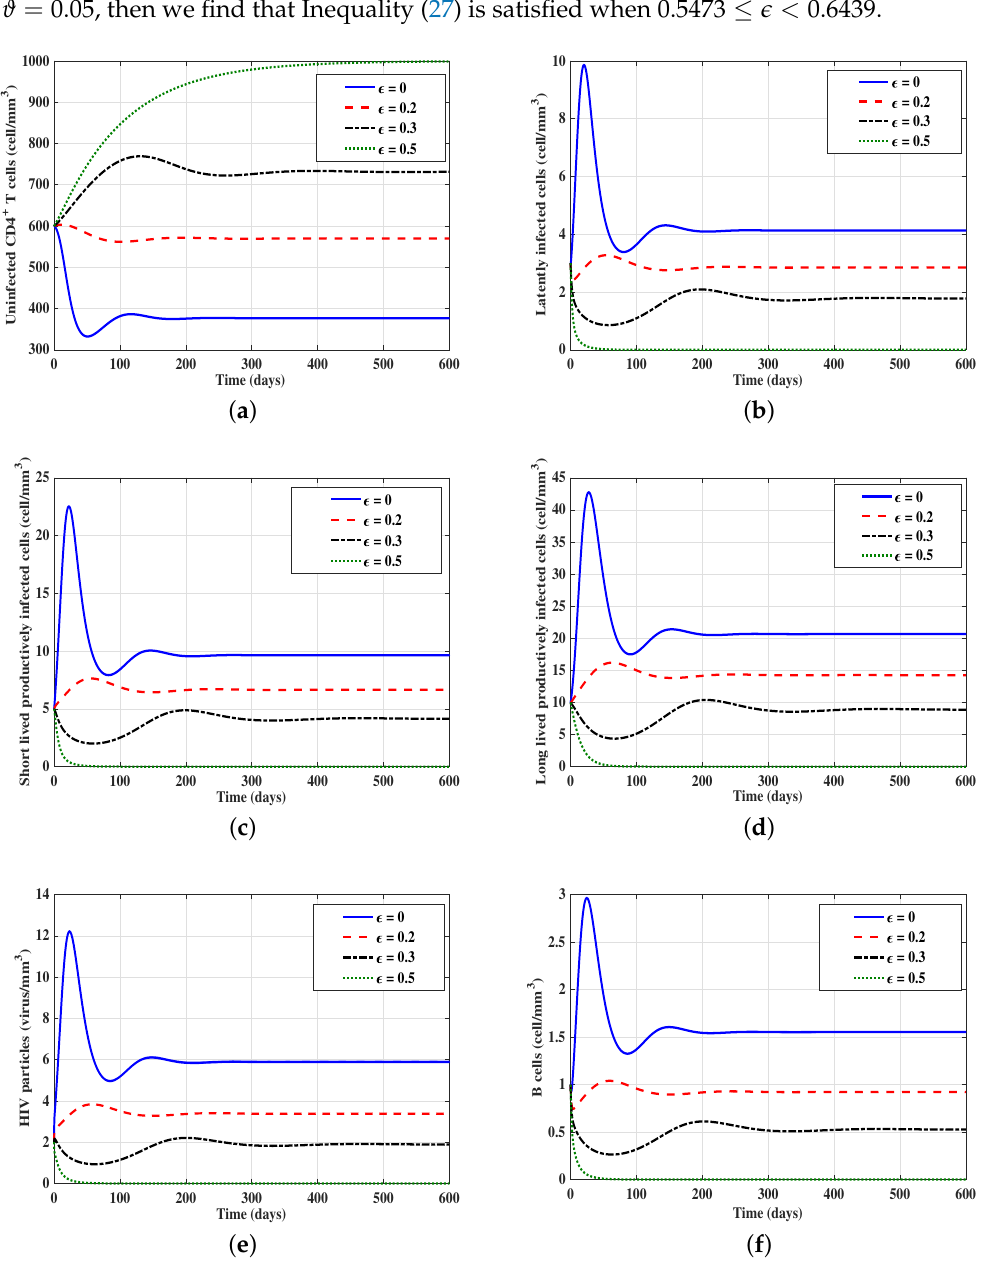
Figure 4. Effect of the drug efficacy parameter (cid:101) on the solution trajectories of models (21)–(26) with initial condition IC6. For this figure, we used. We take α 1 = 0.0001, α 2 = 0.005, ϑ = λ = 0.01 and µ = 0.7. ( a ) Uninfected CD4 + T-cells; ( b ) latently-infected cells; ( c ) short-lived productively-infected cells; ( d ) long-lived productively-infected cells; ( e ) HIV particles; ( f ) B-cells. Therefore, if we apply treatment with efficacy (cid:101) such that 0.3486 ≤ (cid:101) ≤ 0.5473, this guarantees that P 1 ( (cid:101) ) ≤ 0.5 for Model (I), but P 1 ( (cid:101) ) > 0.5 for Model (II). Therefore, more accurate drug efficacy, which is required to reduce the concentration of the HIV to a lower value is calculated by using Model (II). This shows the importance of considering the effect of immune impairment in the HIV dynamics